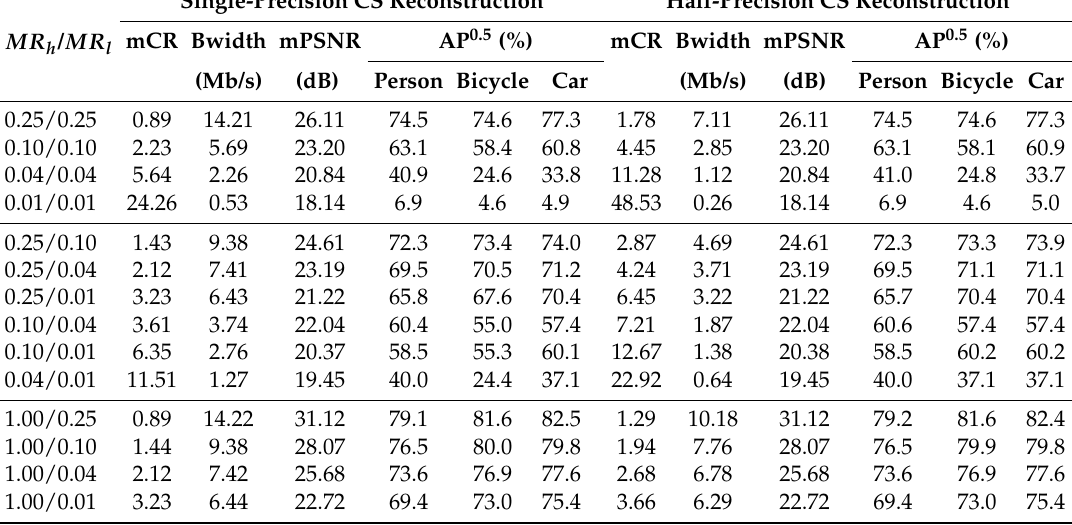
Table 3. Performance of MRCS for CS sampling and reconstruction with multiple MRs. Bwidth denotes the size of required network bandwidth for real-time transmitting CS measurements generated when MRCS samples 25 images per second. AP 0.5 denotes the accuracy predicted for one certain class on the VOC-revise dataset when the value of IoU is